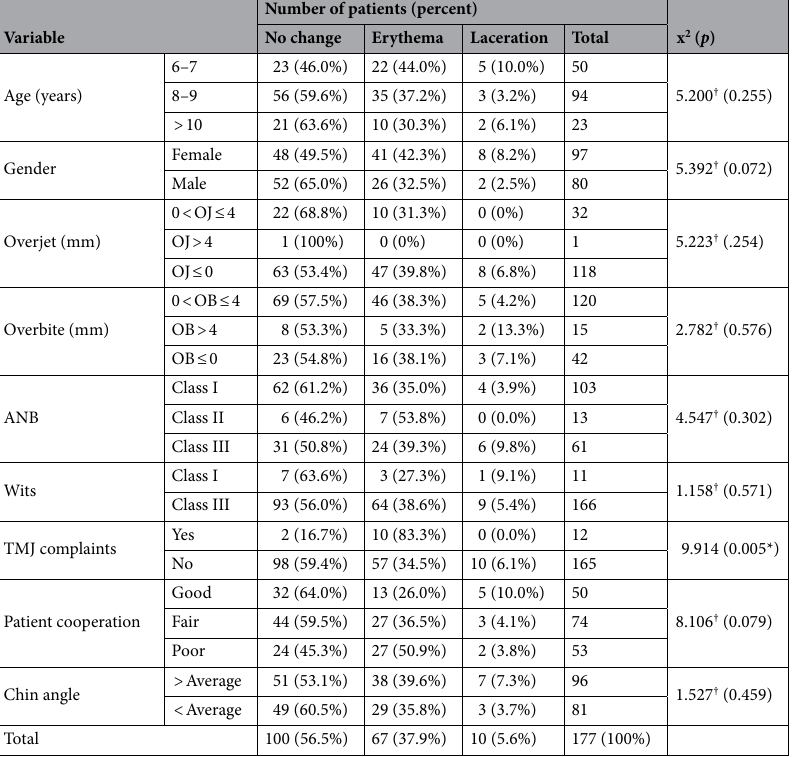
Table 5. The proportion of patients by type of skin irritation according to the variables. * p < .05. † Fisher’s exact